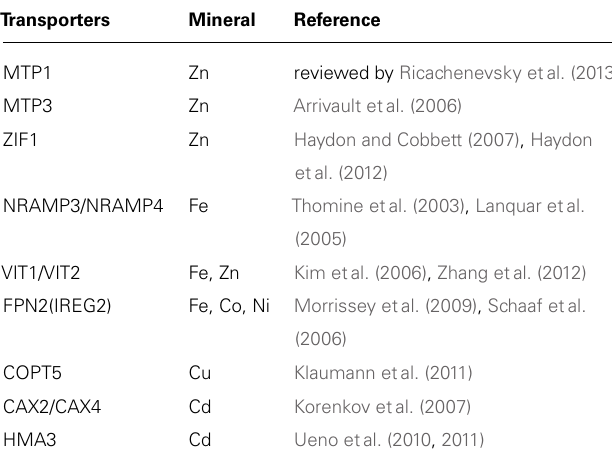
Table 1 |Tonoplast-located transporters that have impact on long-distance transport of metal micronutrients (or toxic metals) in